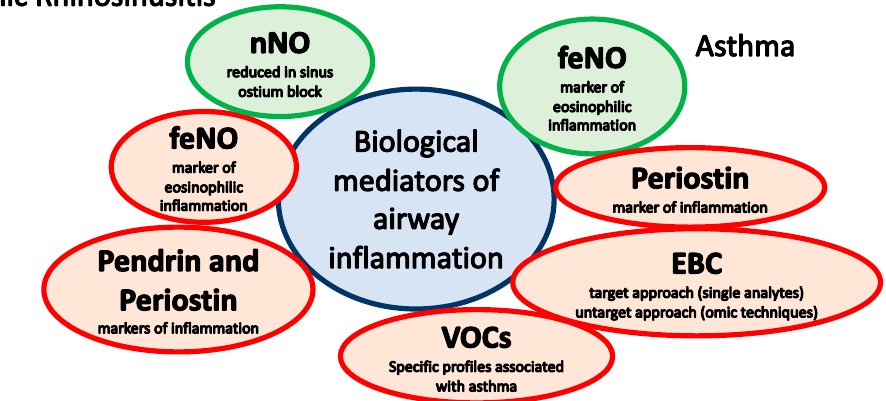
Figure 1. Biological mediators in pediatric rhinosinusitis and asthma. Green: applicable to clinical practice; Red: not applicable to clinical practice yet. nNo: nasal nitric oxide; feNO: fractional exhaled nitric oxide; EBC: exhaled breath condensate; VOCs: volatile organic compounds.